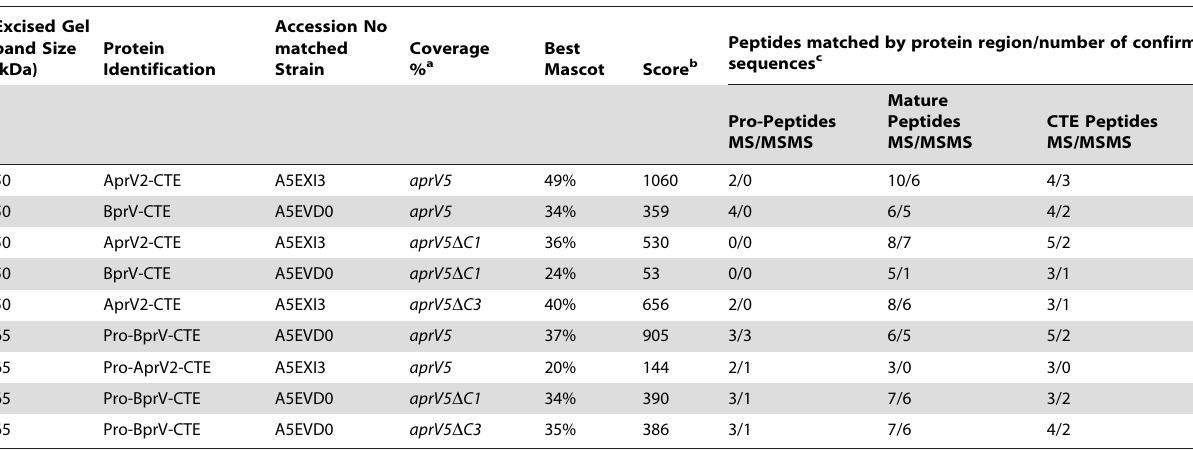
Table 2. Identification of unprocessed proteases in the aprV5 mutant and aprV5 D C strains by mass spectrometry.